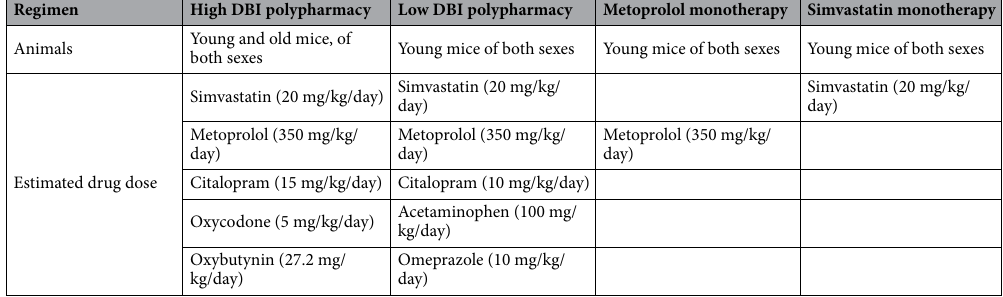
Table 3. Medications including estimated daily dose administered in each polypharmacy and monotherapy group. Therapeutic doses were estimated from previous investigations of chronic oral monotherapy of these drugs in mice, based on the observed food intake of 0.11 g food/g body weight/day. Medications in the required doses were mixed with control diet to make up the medicated feeds, or being administered in drinking water (as for oxycodone, to comply with the requirements for safe handling and storing opioid drugs). DBI drug burden